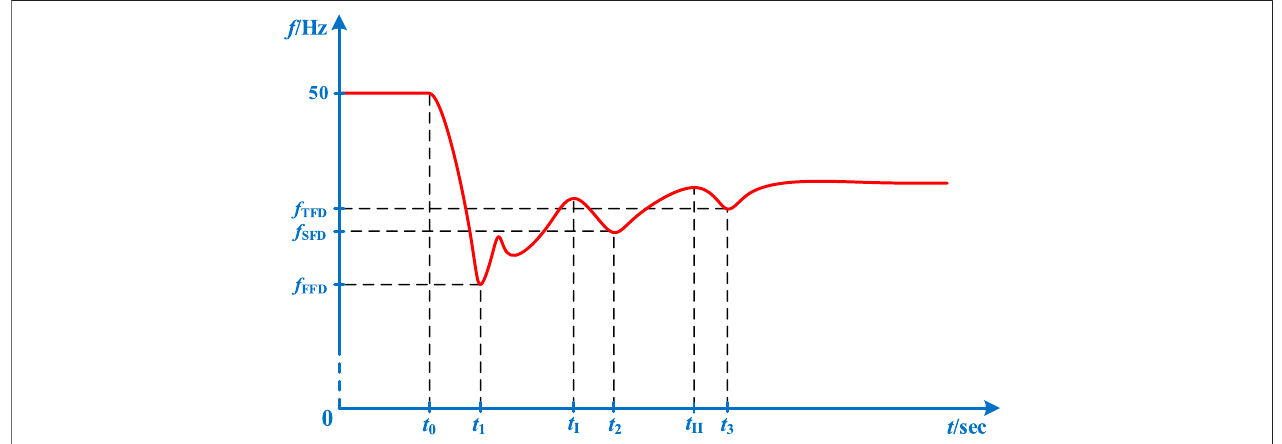
FIGURE 4 | General dynamic characteristics of system frequency under load increase.